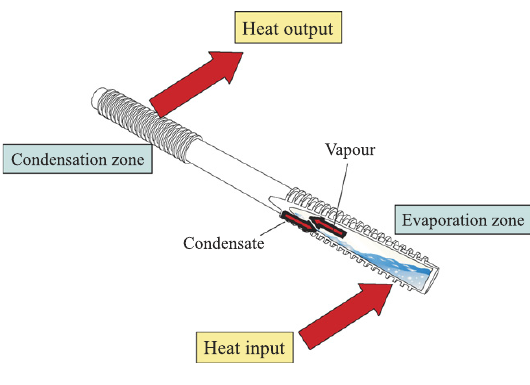
Figure 8 . The operational principle of a heat pipe (from